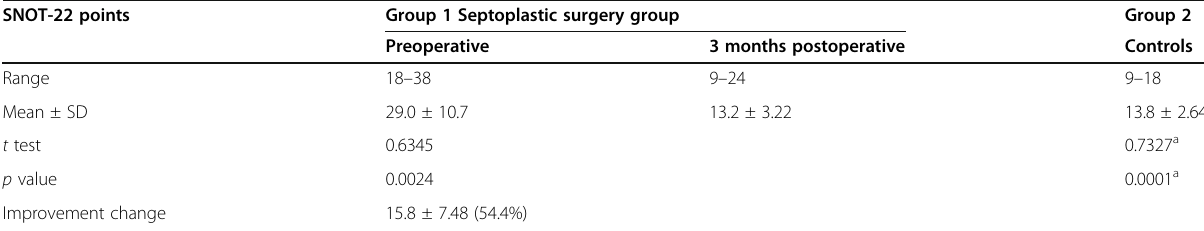
Table 3 Sino-Nasal Outcome Test-22 score of the studied groups SNOT-22